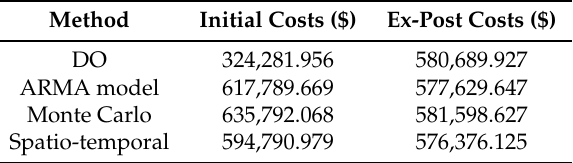
Table 9. The costs of the methods.